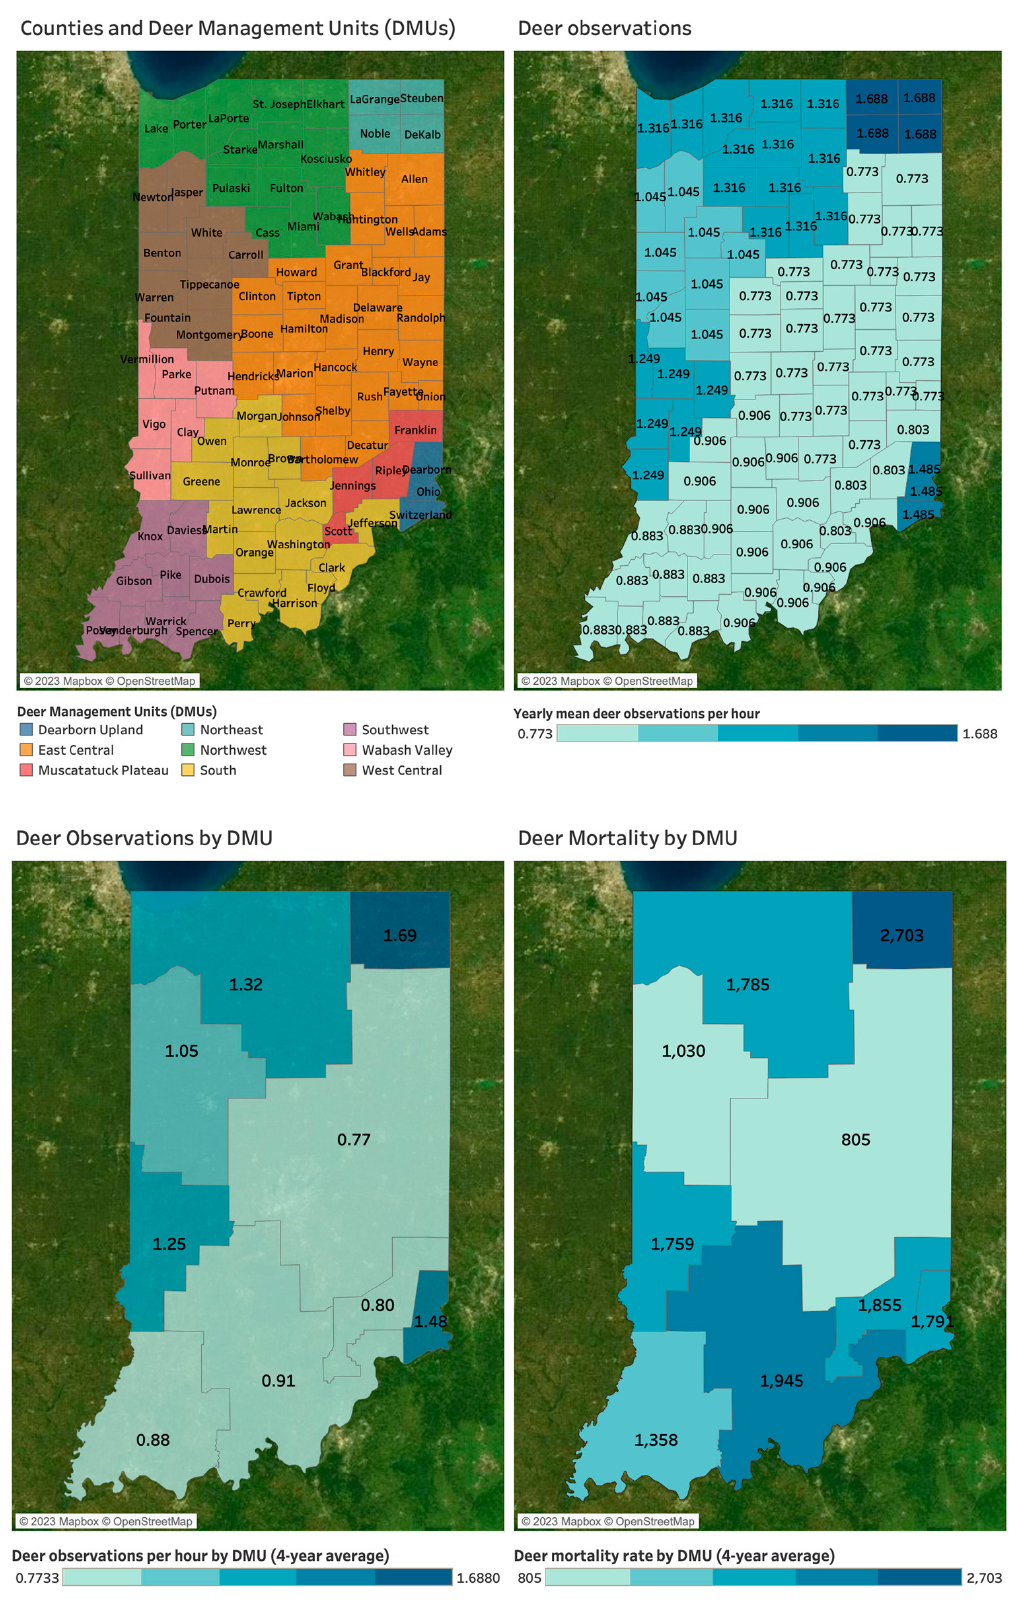
Figure 2. DMUs, deer observations per hour, and deer mortality rate by DMU (4-year average between 2017 and